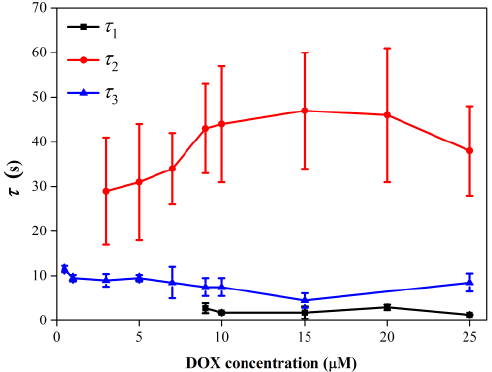
Figure 8. The time constants obtained from the fittings in Figures 4 and 5 plotted as a function of DOX concentration. Exponential function as E SHG = B + A exp ( − ( t − t 0 ) / τ ) (for TPF experiments at all concentrations and SHG experiments at relatively low concentrations of 3–7 µ M) or a bi-exponential function as E SHG = B + A 1 exp ( − ( t − t 0 ) / τ 1 ) + A 2 exp ( − ( t − t 0 ) / τ 2 ) (for SHG experiments at relatively high concentrations of 9–25 µ M) was applied in the fittings as discussed in the main text. In this plot τ 1 represented the rate of the fast SHG change in experiments with DOX at relatively high concentrations, τ 2 indicated the rate of the slow change in all the SHG curves. Therefore, τ 1 was absent for experiments at relatively low concentrations. τ 3 reflected the rate of exponential change in TPF curves as shown in Figure 5. Note that the curve of τ 2 was higher than the curve of τ 3 as discussed in the main text. Reproduced with permission [57]. Copyright 2019